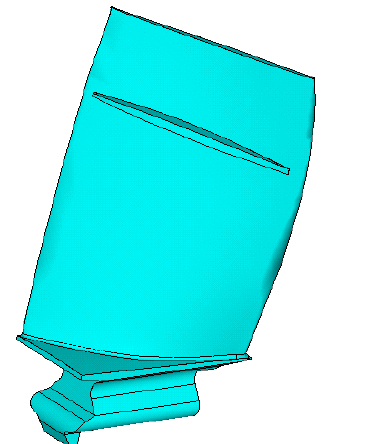
Figure 4. Single-blade model of Stage 1.